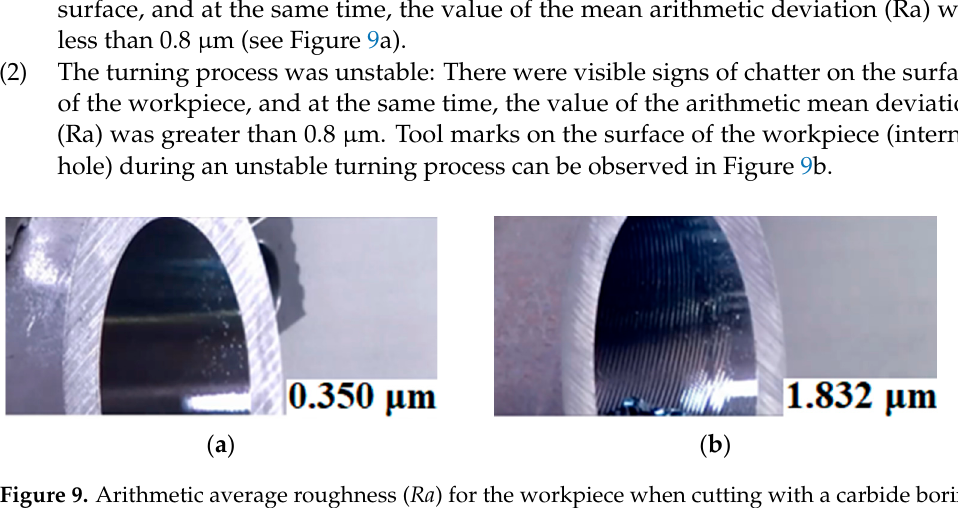
Figure 8. Circularity profile of the workpiece when cutting with a carbide boring bar: ( a ) in stable condition in 2D; ( b ) in stable condition in 3D at TSC = 4 mm − 1 ; ( c ) unstable condition in 2D; ( d ) unstable condition in 3D at TSC = 13.50 mm − 1 .